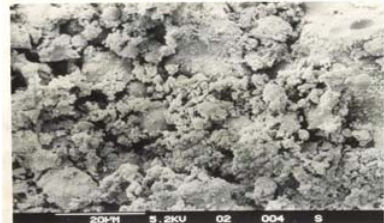
Figure 10 . SEM micrograph of leached LFAS composite containing 20% cement and nickel